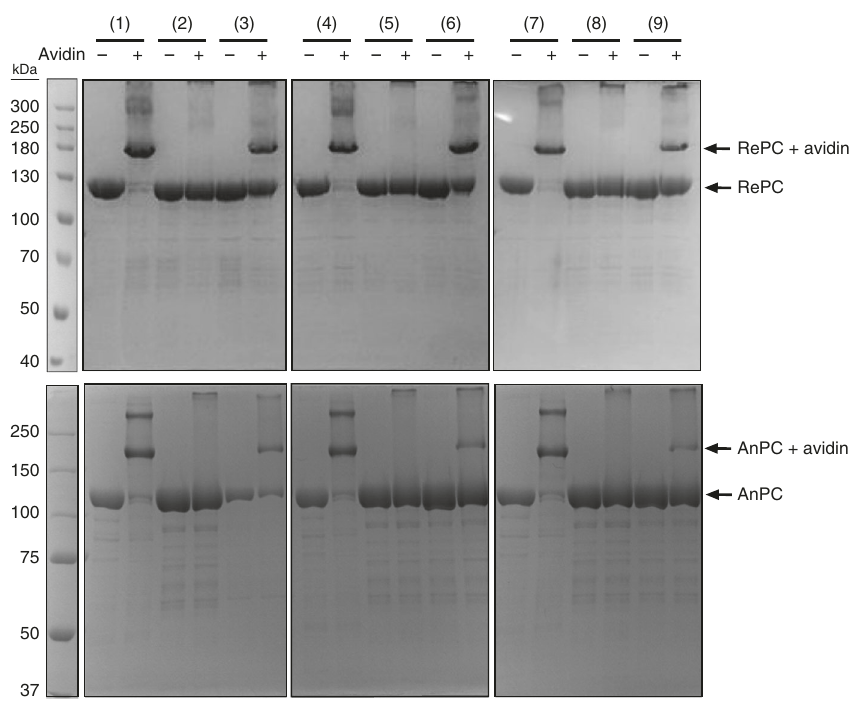
Fig. 5 Hybrid tetramers are produced by co-expression. Avidin gel shift assays showing the successful production of all three co-expression products of RePC and AnPC. (1) ×BC; (2) ×CT×BCCP; (3) ×BC/×CT×BCCP; (4) ×CT; (5) ×BC×BCCP; (6) ×CT/×BC×BCCP; (7) ×BC×CT; (8) ×BCCP; (9) ×BCCP/